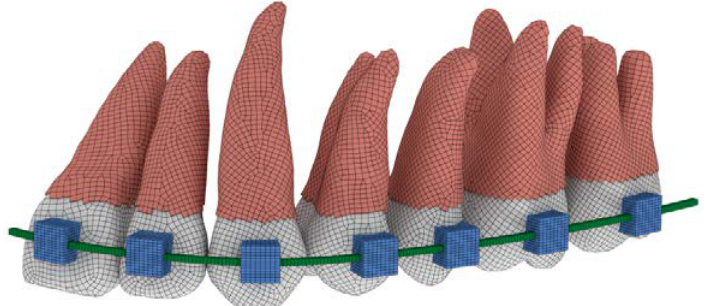
Figure 2. FE model of the upper left dentition with 0.022-inch brackets and a 0.019 × 0.025-inch archwire .